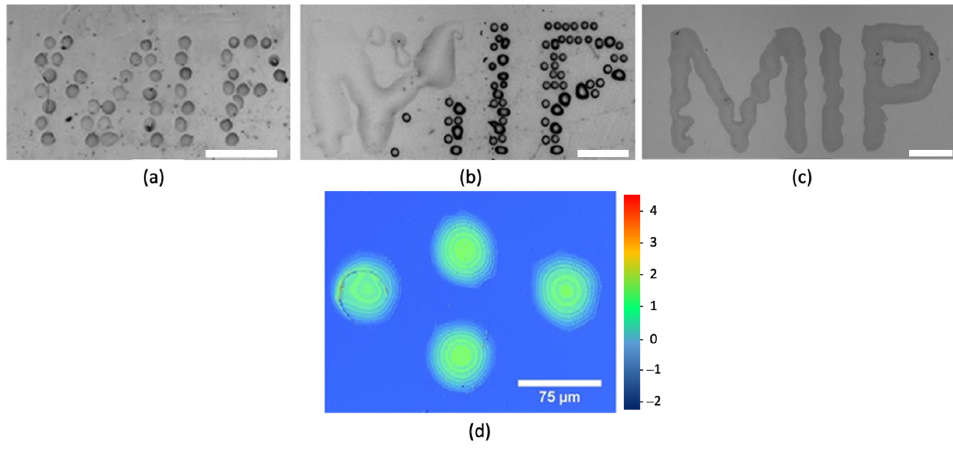
Figure 2. ( a – c ) Brightfield images of polymerized “MIP” pattern inkjet-printed with different droplet spacing results in separated droplets, half merged droplets, and total merged droplets. The scale bar is 800 μ m; ( d ) optical profilometer image of the separated inkjet-printed polymer droplets.